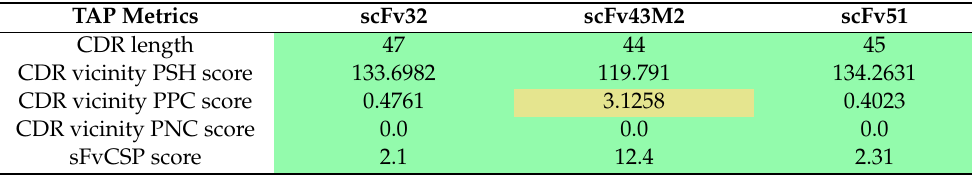
Table 3. Therapeutic Antibody Profiling of ScFv